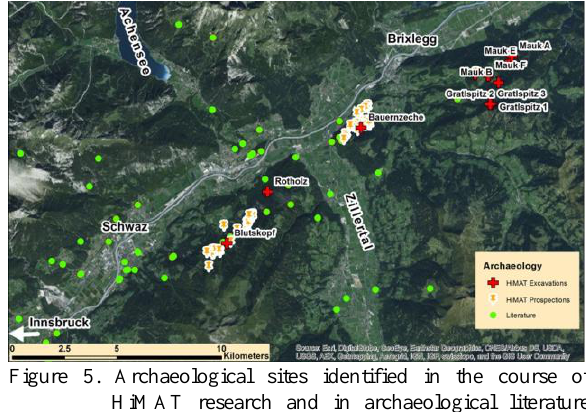
Figure 5. Archaeological sites identified in the course of HiMAT research and in archaeological literature (source: